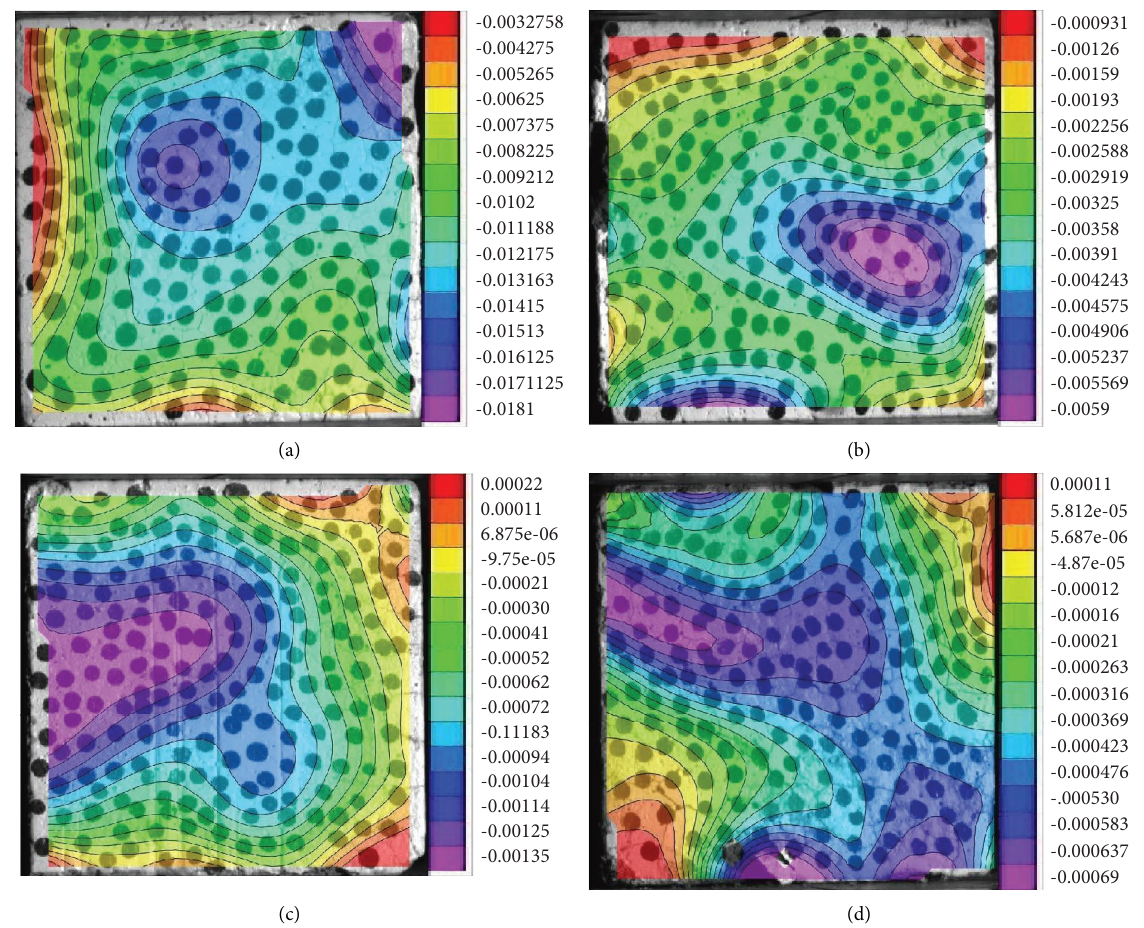
Figure 21: Vertical strain cloud diagram of glass fber-reinforced cemented soil in salt solution environment after 5 cycles: (a) water environment; (b) potassium acetate environment; (c) magnesium chloride environment; (d) sodium sulfate